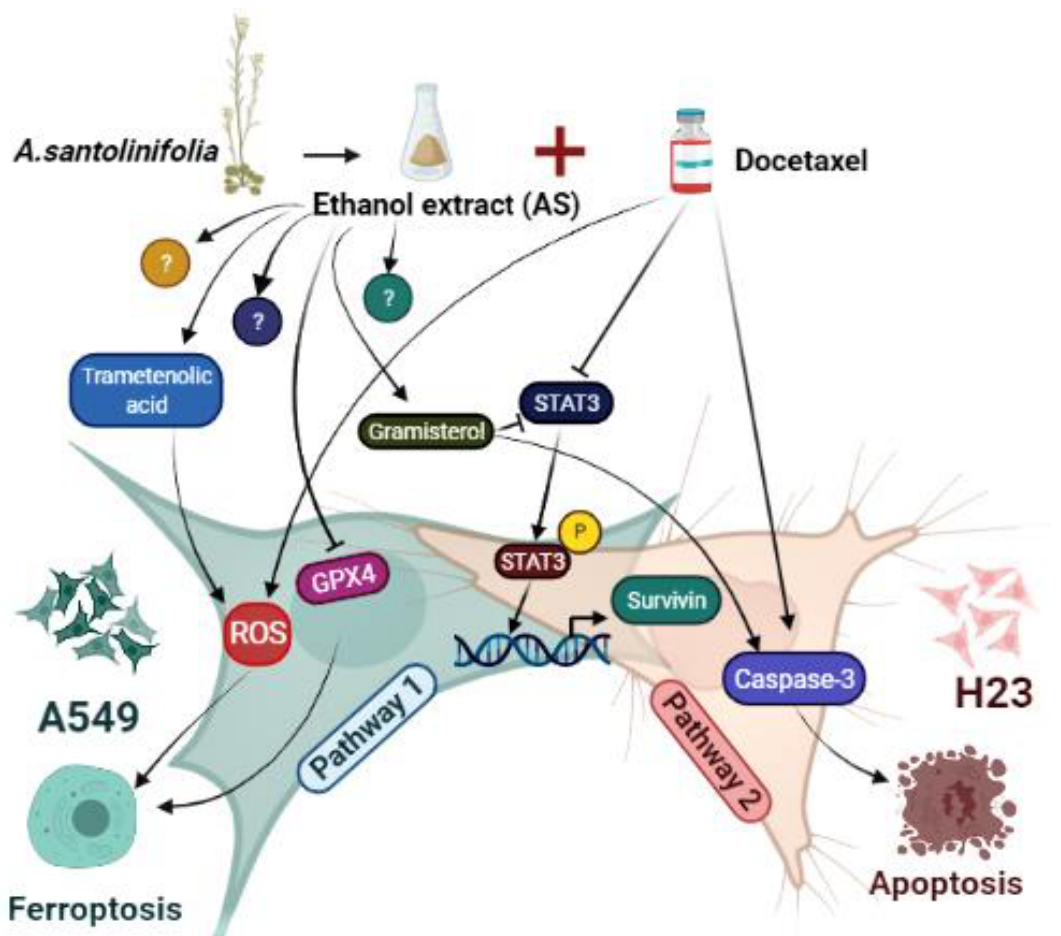
Figure 5. AS-mediated chemosensitization via activation of distinct cell death modes in NSCLC. Black arrows indicate the activity of AS and DTX; blocked black arrows denote inhibited signaling molecules.